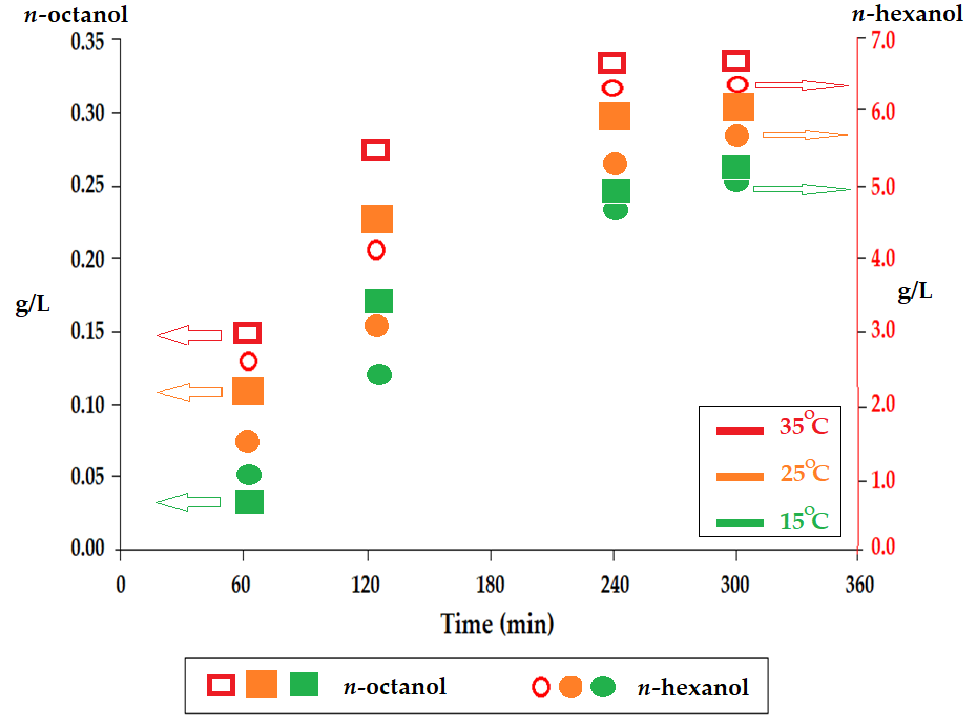
Figure 6. Loss of membrane solvent in the source phase depending on the operating temperature for n -octanol and n -hexanol.